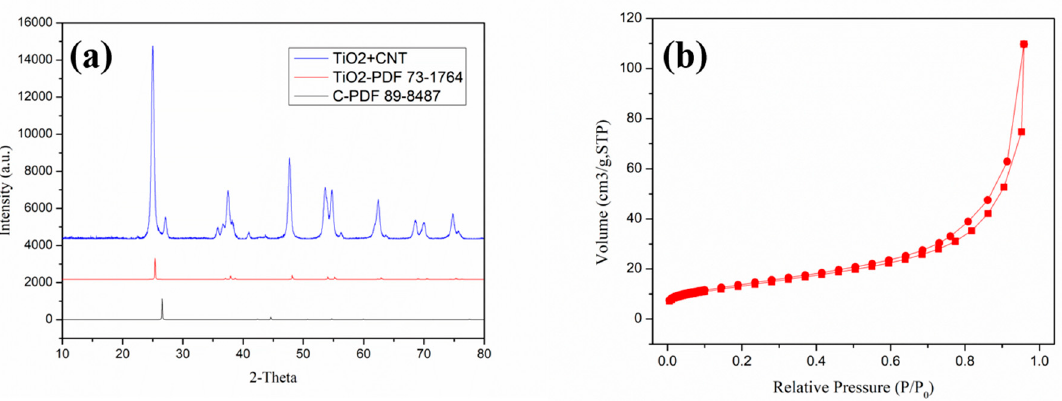
Figure 4. XRD pattern ( a ) and nitrogen adsorption–desorption isotherms ( b ) of the TiO 2 /CNT mesoporous composite.